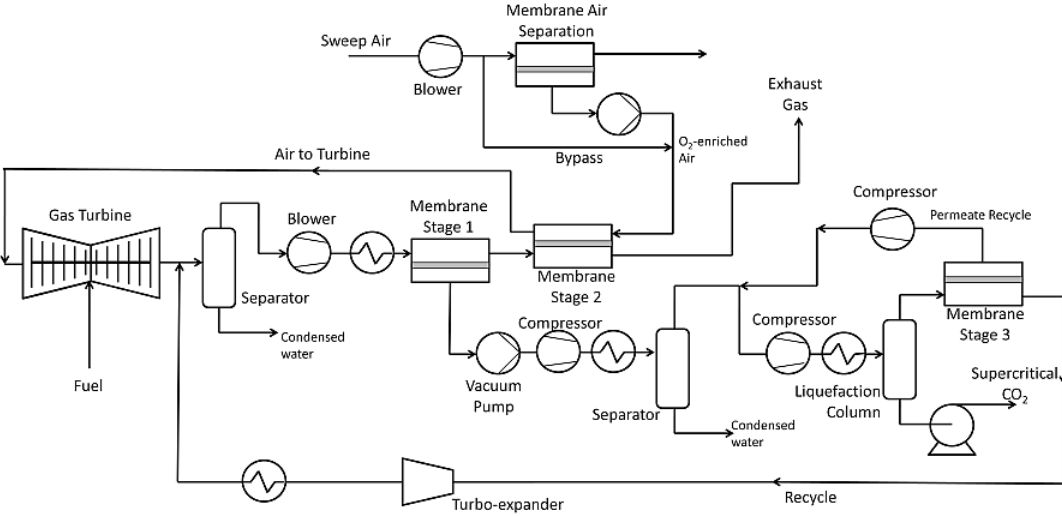
Figure 1. Three CO 2 -membrane stages with liquefaction and O 2 -enrichment for post-combustion capture from a gas turbine.